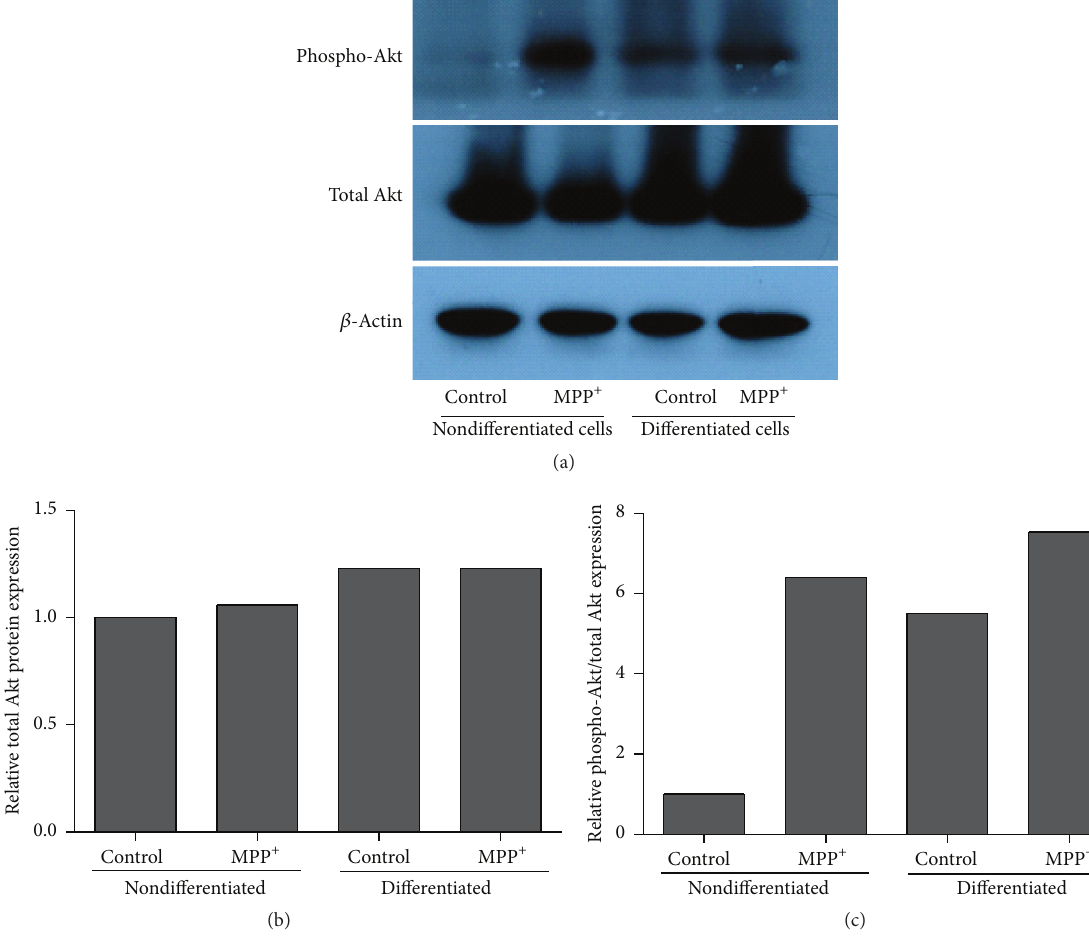
Figure 6: Relative protein expression of total Akt and phospho-Akt in nondifferentiated and differentiated SH-SY5Y cells by Western blot. For neuronal differentiation, SH-SY5Y cells were treated with 10 𝜇 M retinoic acid for three days before exposure to MPP + . The control groups for nondifferentiatedanddifferentiatedSH-SY5YcellsweretreatedwiththesamemediumwithoutMPP + .(b)and(c)representthequantification of the band density of total Akt and phospho-Akt, respectively. The band density was normalized to actin and relative to a nondifferentiated